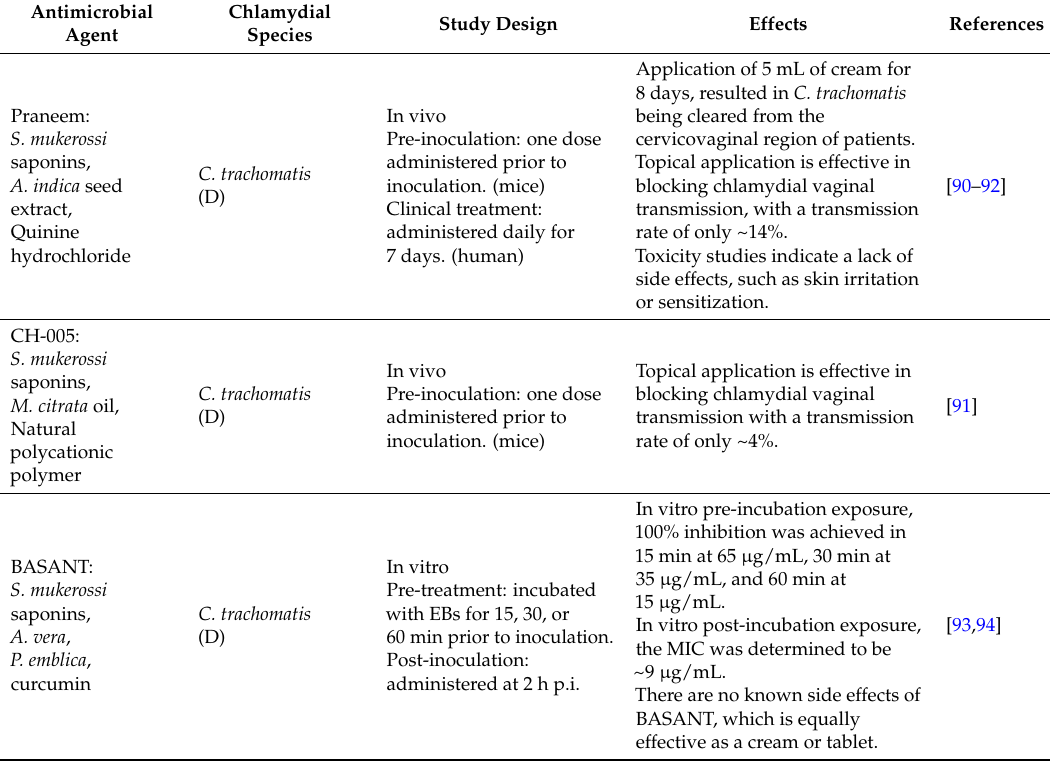
Table 6. Past studies exploring antichlamydial properties of polyherbal